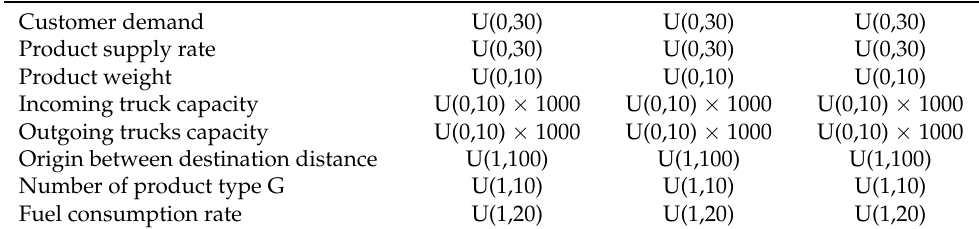
Table 15. Random parameters of the